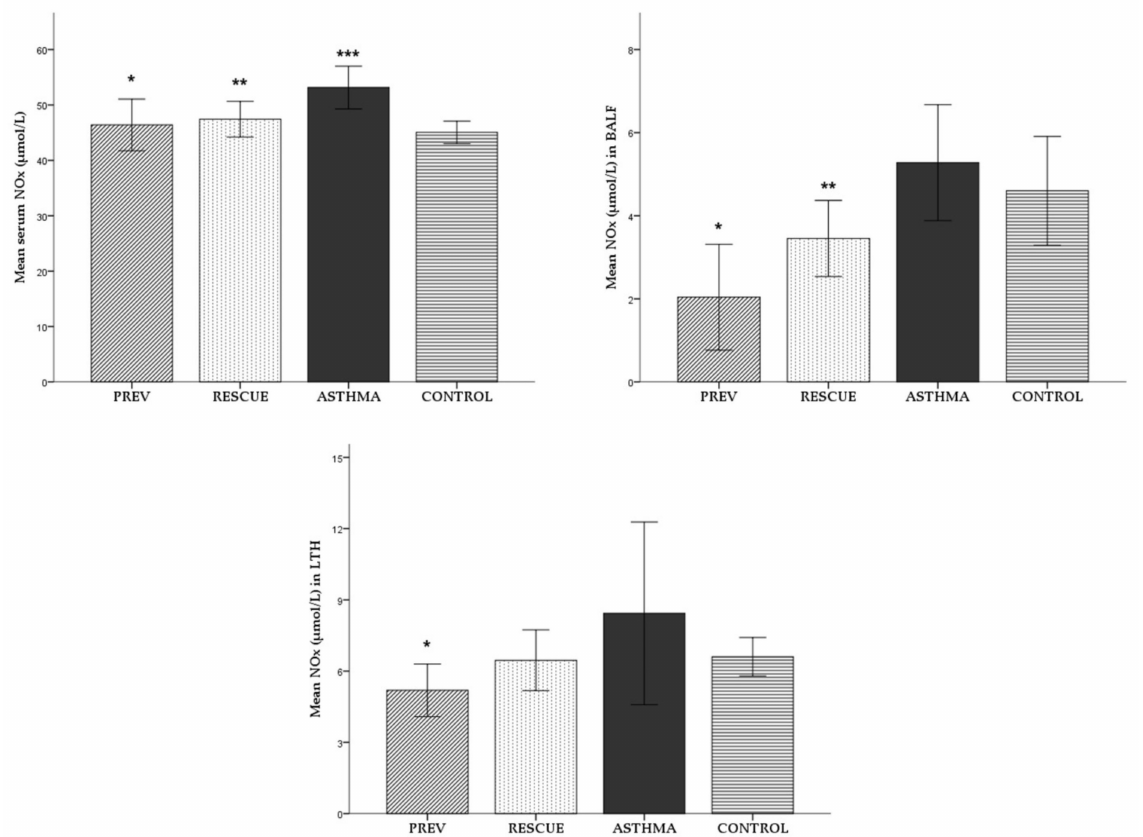
Figure 5. NOx levels in serum, BALF and LTH. Values are expressed as mean ± SD. Comparison between experimental groups: * p < 0.05 PREV versus ASTHMA group; ** p < 0.05 RESCUE versus ASTHMA group; *** p < 0.05 ASTHMA versus CONTROL. Abbreviations: BALF = broncho-alveolar lavage fluid; LTH = lung tissue homogenate; NOx = level of inorganic nitrites and nitrates; PREV = long-term low-dose vitamin D supplementation, RESCUE = short-term high-dose vitamin D supplementation, ASTHMA = positive control, CONTROL = negative control. Note: a Mann–Whitney test was applied for the analysis of LTH NOx